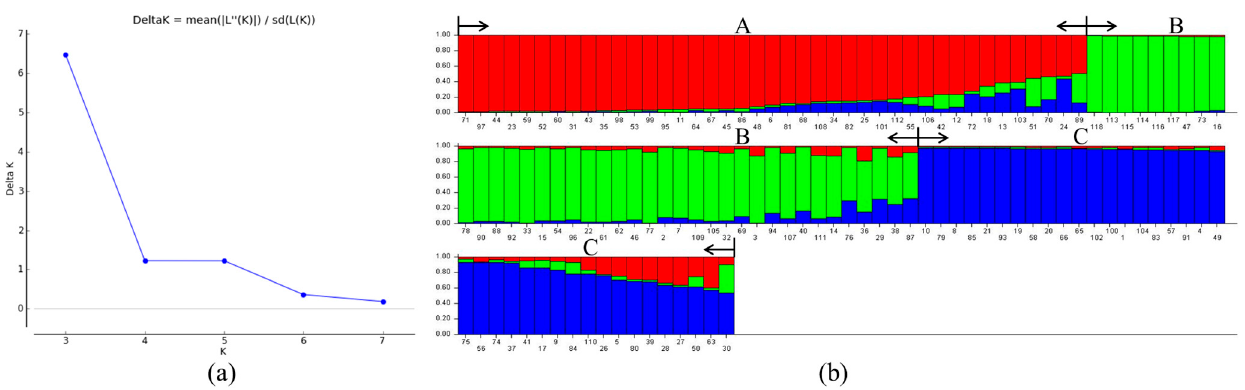
Figure 3. Optimal K-value according to maximum Delta K ( a ) and population structure analysis of 118 Castanea plant materials ( b ). The optimum number of groups is 3, dividing the 118 ingredients into three groups (A, red; B, green; C, blue). The labels on the bottom of ( b ) represent the material number (corresponding to Table S4).